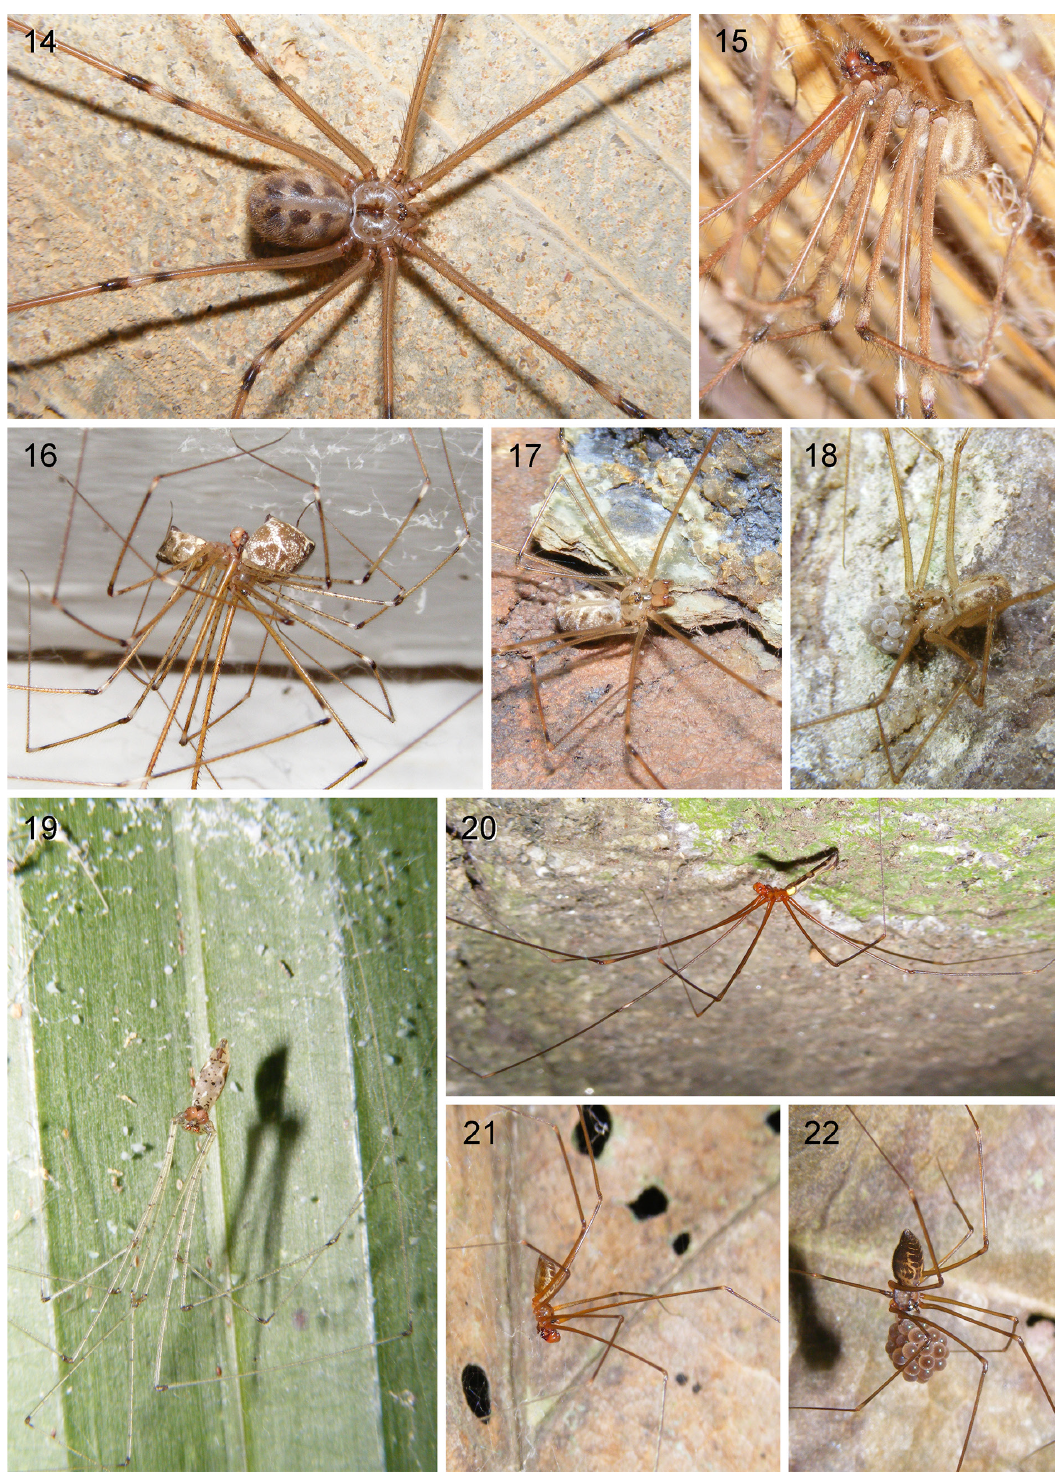
Figs 14-22. 14-15. Artema bunkpurugu sp. nov. from near Bunkpurugu (14) and from Bunkpurugu (15), Ghana. 16 . Crossopriza lyoni (Blackwall, 1867) from Conakry, Guinea. 17-18 . Physocyclus globosus (Taczanowski, 1874) from near Mpraeso, Ghana. 19 . Smeringopus cylindrogaster (Simon, 1907) from Ankasa N.P., Ghana. 20 . Smeringopina pulchra (Millot, 1941) from Kakum N.P., Ghana. 21-22 . Smeringopina bomfobiri Huber, 2013 from Atewa, Ghana. Photos